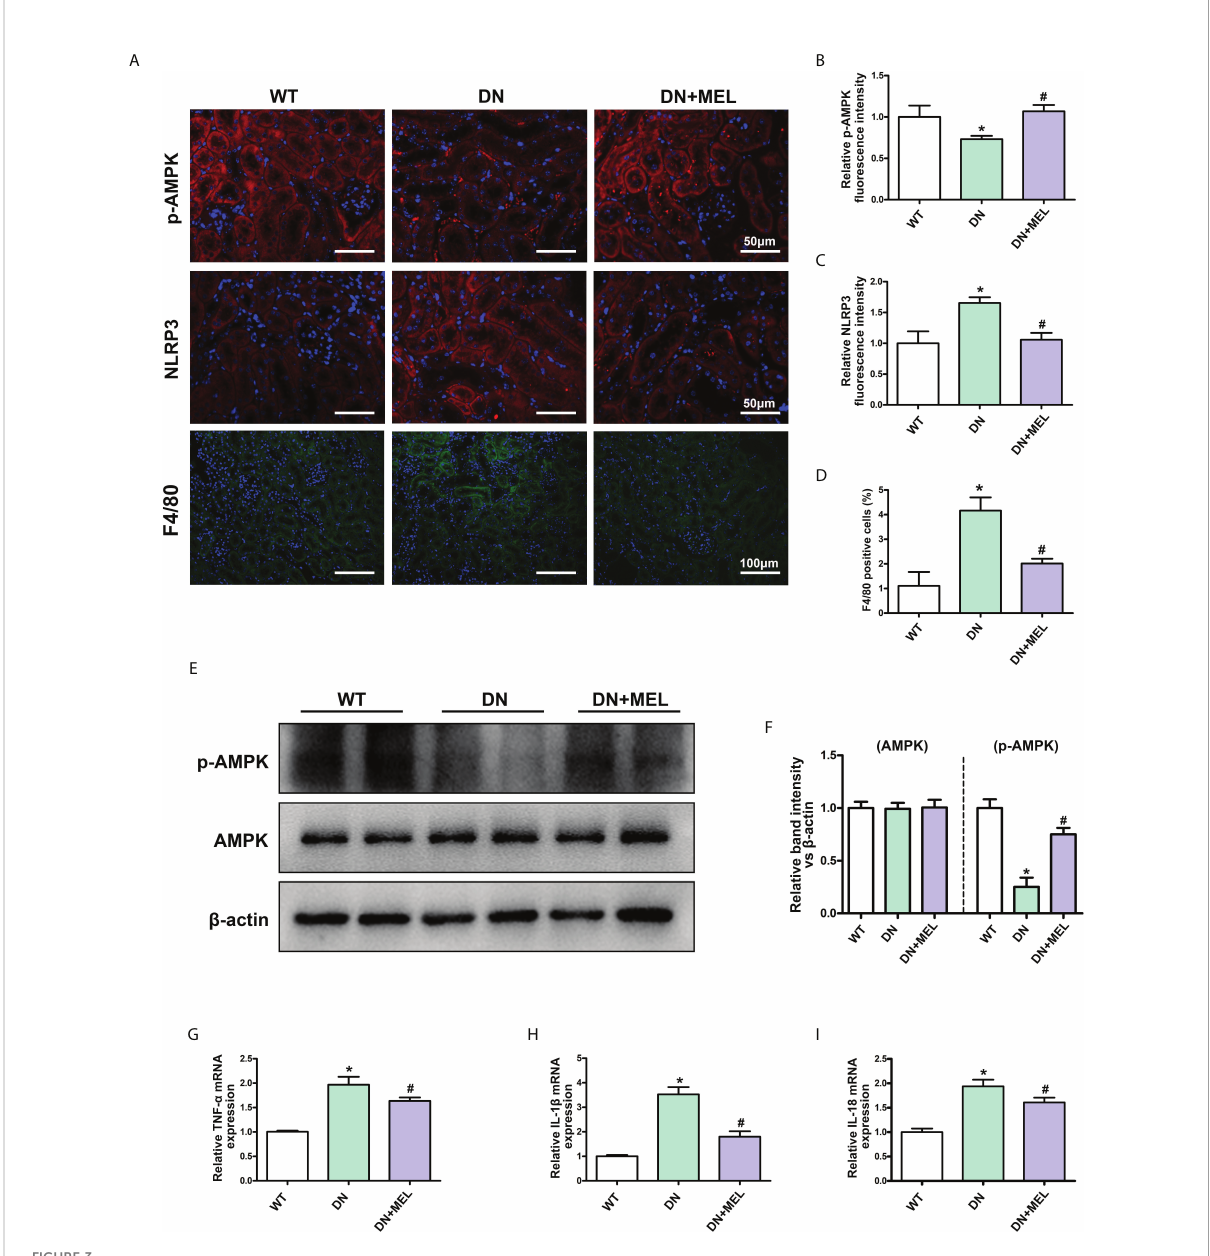
FIGURE 3 The effects of melatonin on the expression of p-AMPK and in fl ammation in the kidneys of DN mice. IHF analysis of p-AMPK ( A , upper panel, B ), NLRP3 ( A , middle panel, C ), and F4/80 ( A , lower panel, D ) in the kidneys of different groups. Western blot analysis revealed the expression of p- AMPK and AMPK (E, F) . The mRNA levels of TNF- a (G) , IL-1 b (H) , and IL-18 (I) in the different groups. The values are the mean ± SD. n = 6/ group. *p < 0.05 compared with the control group; # p < 0.05 compared with the DN